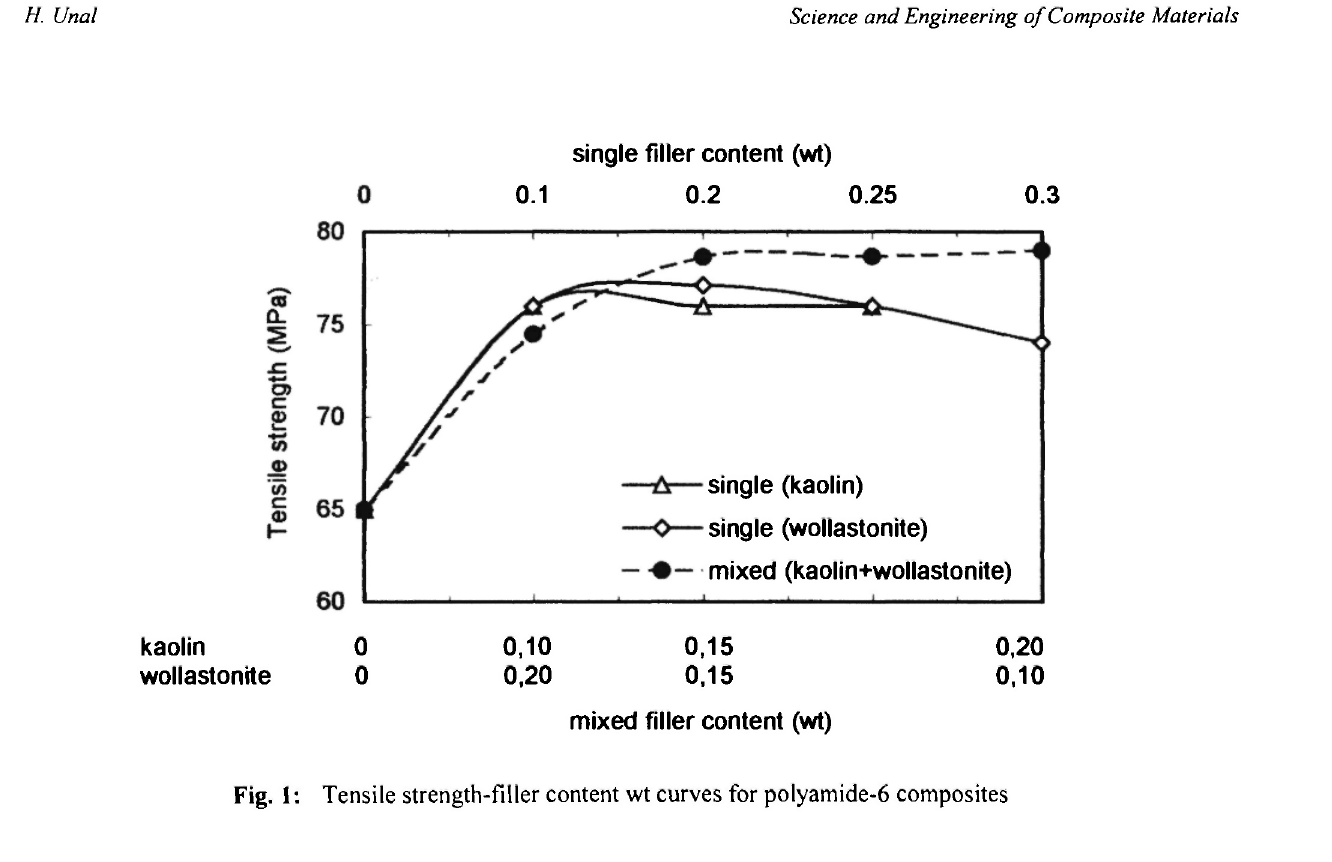
Fig. 1: Tensile strength-filler content wt curves for polyamide-6 composites